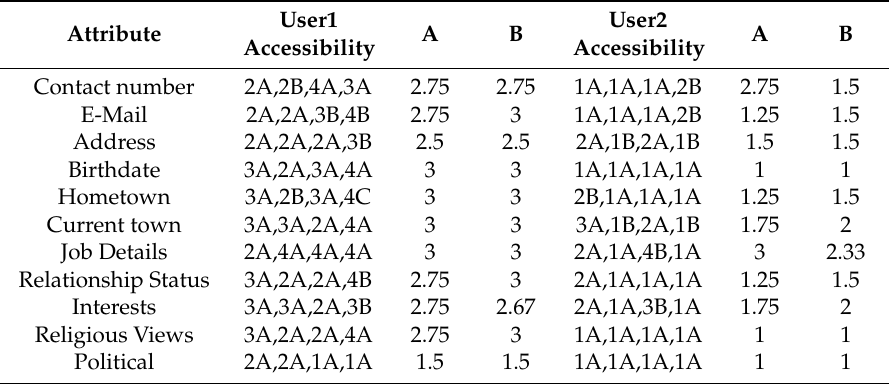
Table 5. Attribute accessibility and content.